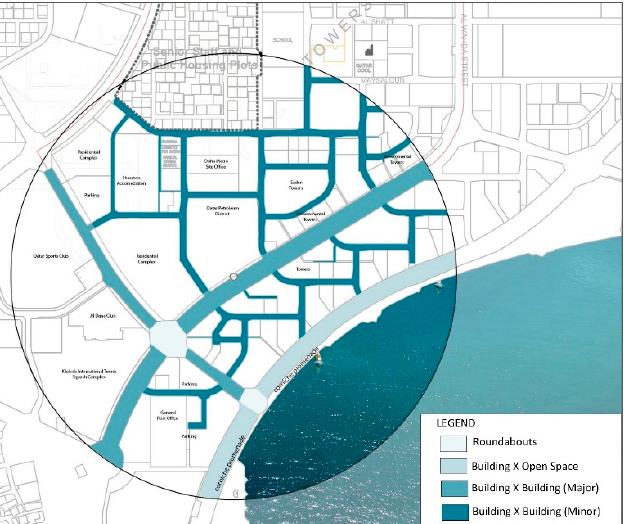
Figure 17. Various street prototypes at the study site, categorized in relation to walkability (Source: the Authors).